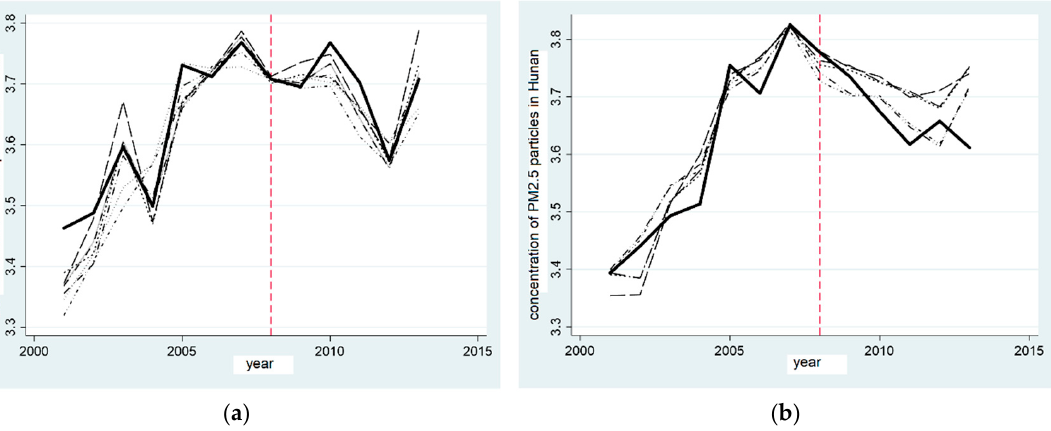
Figure 6. Sensitivity analysis of PM2.5 density in provinces in the “two-oriented society” pilot zone. ( a ) Hubei; ( b ) Hunan.